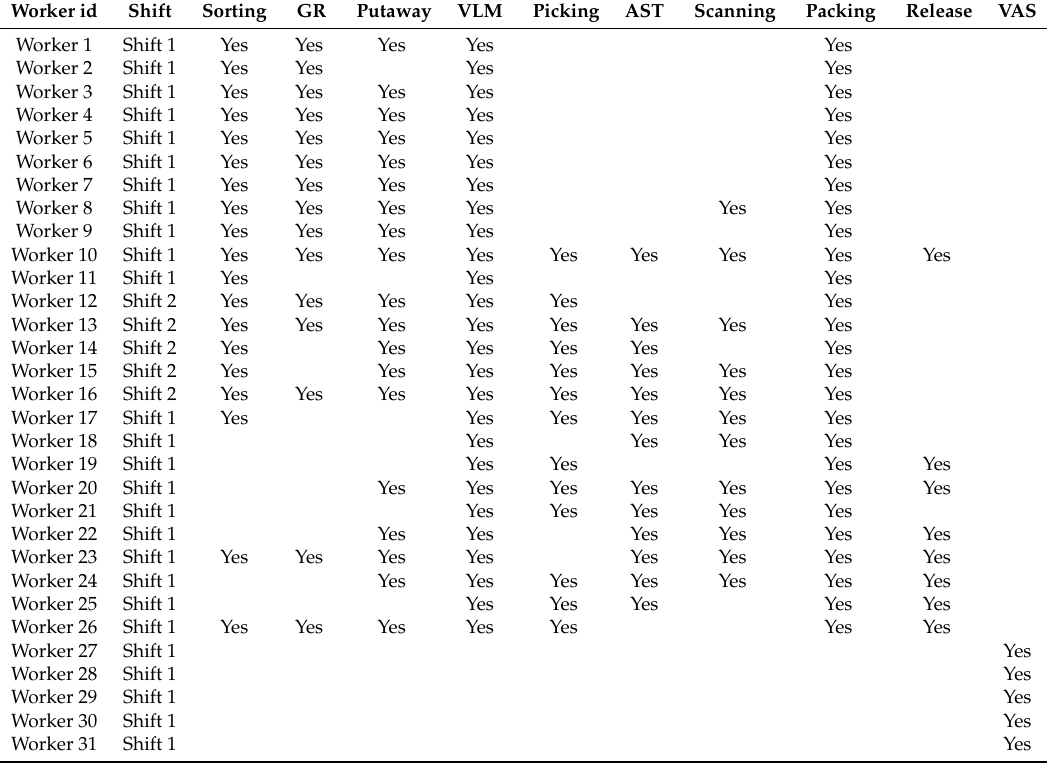
Figure 2. Outbound entity flow diagram. Table 1. Worker skill